Question: Provide a one-line summary of what is displayed.
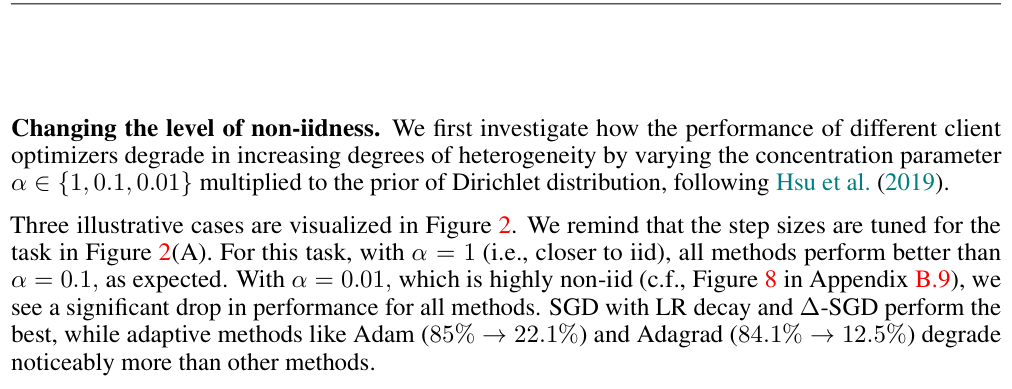
Answer: The effect of stronger heterogeneity on different client optimizers, induced by the Dirich- let concentration parameter α ∈{0.01, 0.1, 1}. ∆-SGD remains robust performance in all cases, whereas other methods show significant performance degradation when changing the level of hetero- geneity α, or when changing the setting (model/architecture).